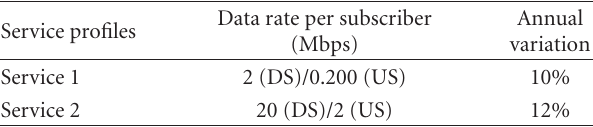
Table 4: Service profile technical